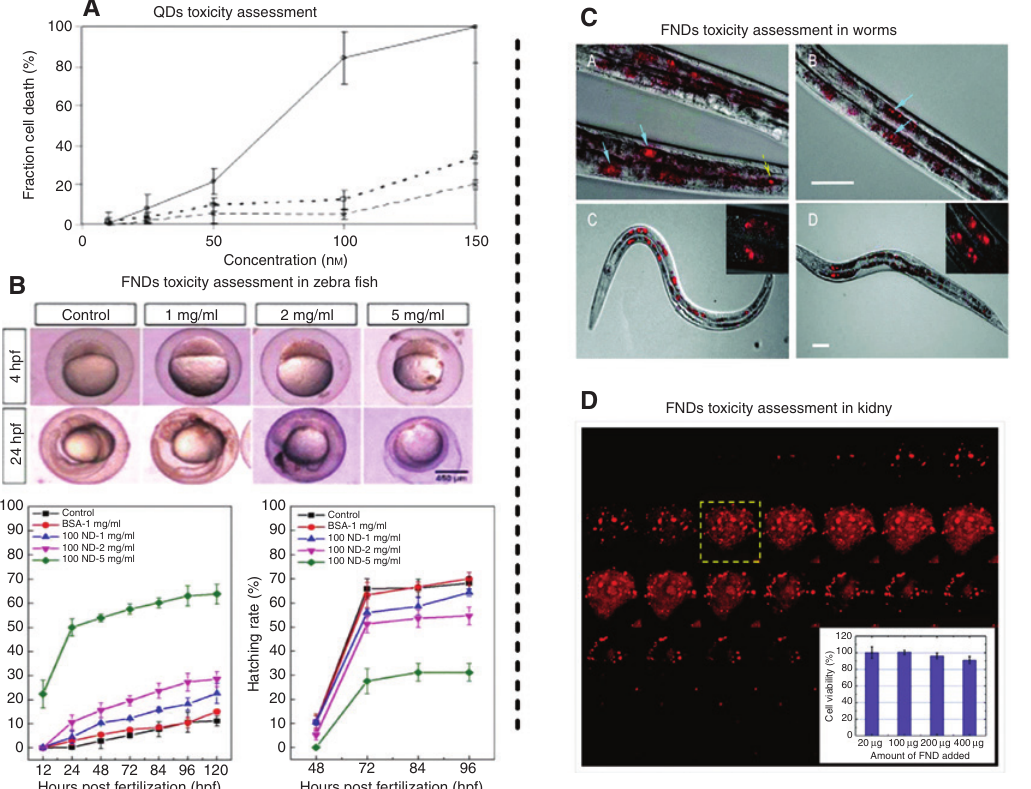
Figure 2: An illustration of toxicity levels of QDs and FNDs in living organisms. (A) Toxicity assessment of cell exposed to QDs for 4 h. The upper curve represents pure QDs without surface modifications. The other curves illustrate QDs with PEG coating at different concentrations (750- and 6000-Mw PEG-substituted QDs). Adapted from [44]. (B) Zebrafish embryos development stages with various concentrations of nanodiamond for different periods at 4-h post-fertilization (hpf) and 24 hpf (upper image in Figure 2B). Mortality and hatching of zebrafish embryos as a function of the NDs concentrations (lower image in Figure 2B). Adapted from [46]. (C) Images of worms fed with FNDs coated with BSA (bovine serum albumin) and DOX (doxorubicin). Insets: 100 × magnified images of the FNDs within the intestinal cells. Adapted from [47]. (D) Optical images of a single human kidney cell after fluorescent nanodiamond uptake. The red spots are the FNDs. Inset: Toxicity assessments of showing the survival percentage of the kidney cells versus the FNDs doses. Adapted from